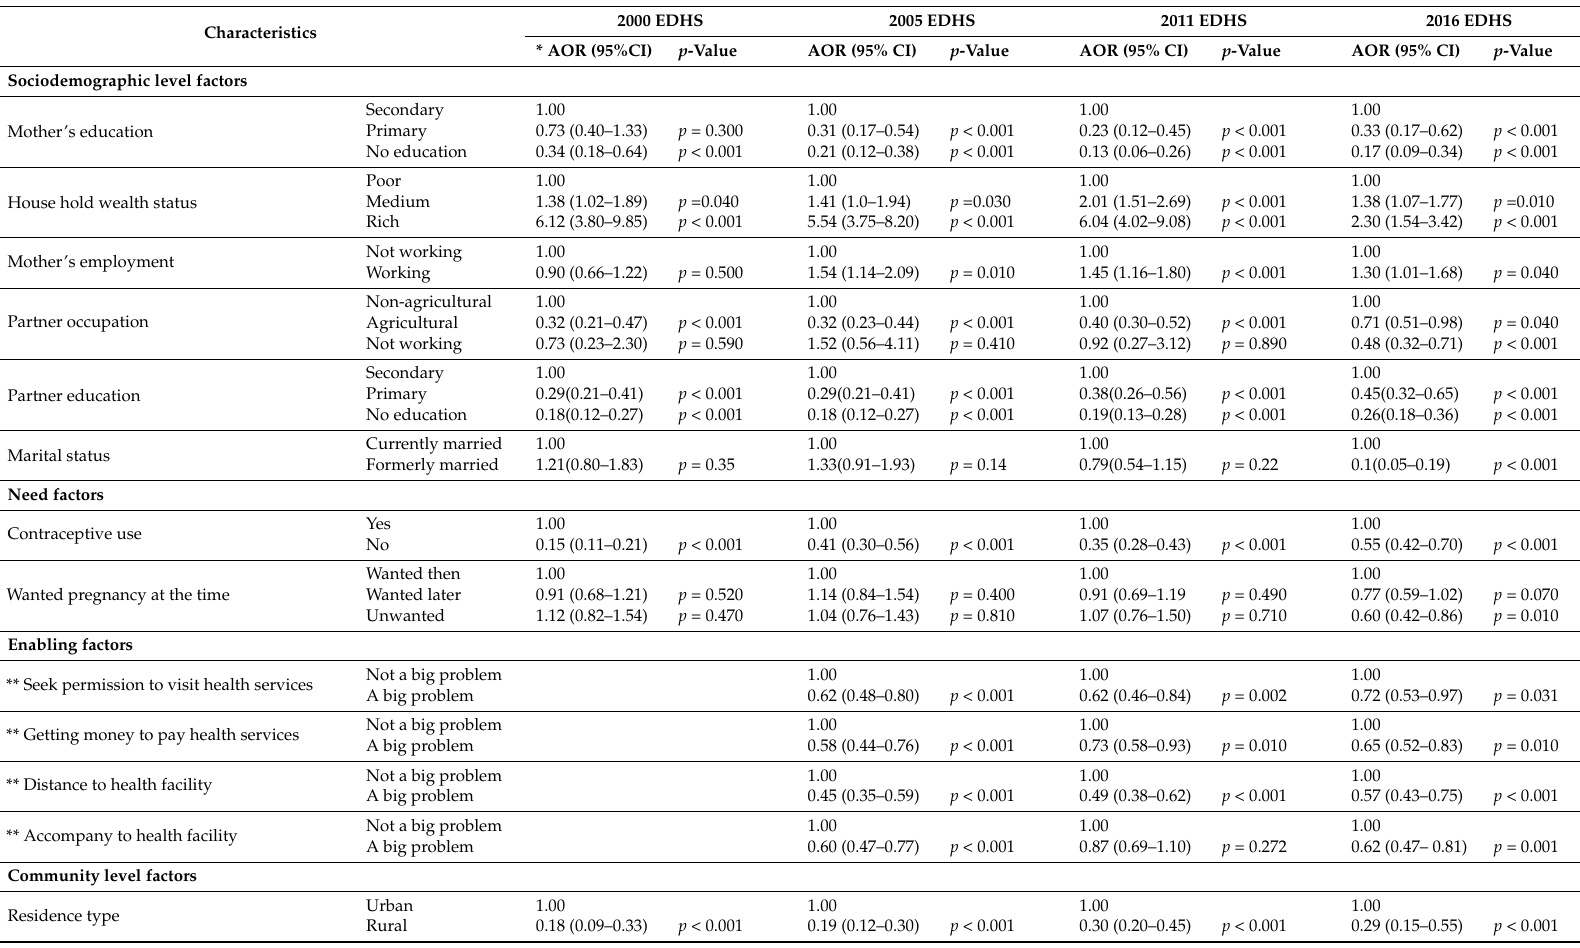
Table 4. Association between the study factors and four or more ANC visits in Ethiopia,